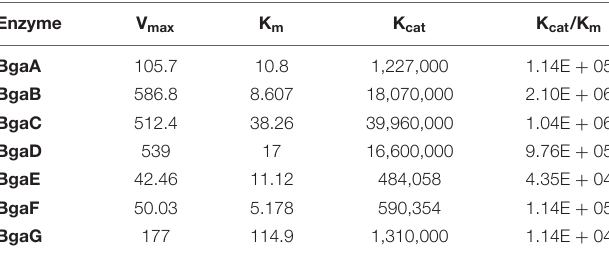
TABLE 3 | Kinetic characterization of enzymes using ONPG as a